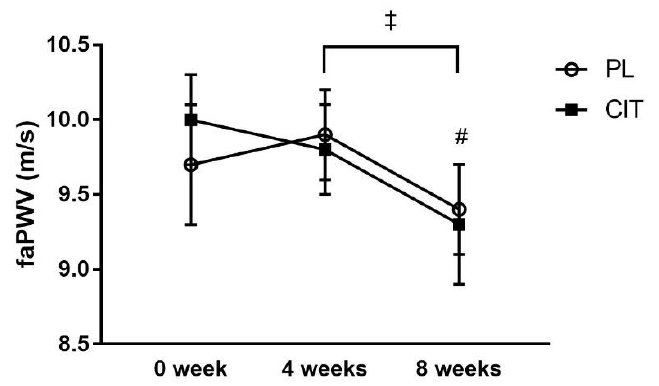
Figure 4. Effects of placebo (PL) and citrulline (CIT) supplementation on femoral-ankle pulse wave velocity (faPWV) after 4 weeks (CIT alone) and 8weeks (CIT and SVLIRT). # p < 0.05 vs. 4 weeks (for both groups); ‡ p < 0.001, time effect.